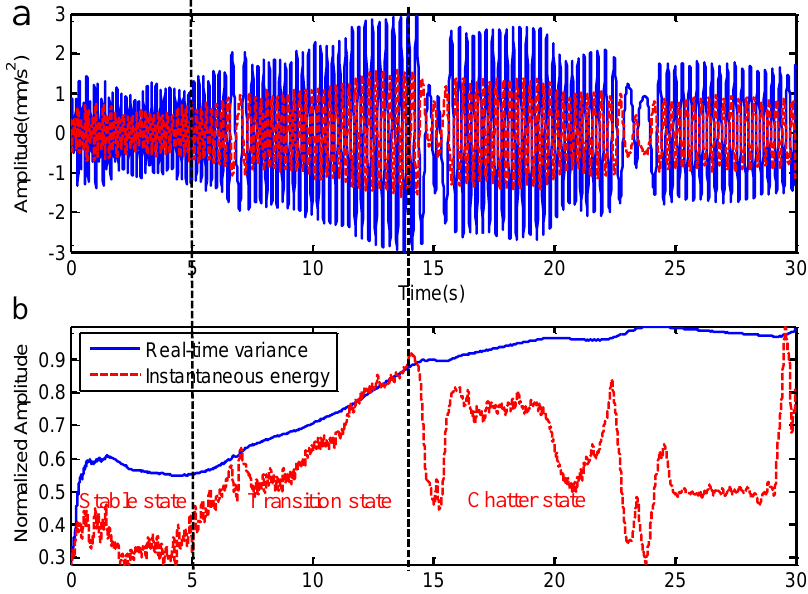
Figure 15. ( a ) Experimental chatter signal; ( b ) Superposed and normalized real-time variance and instantaneous energy.